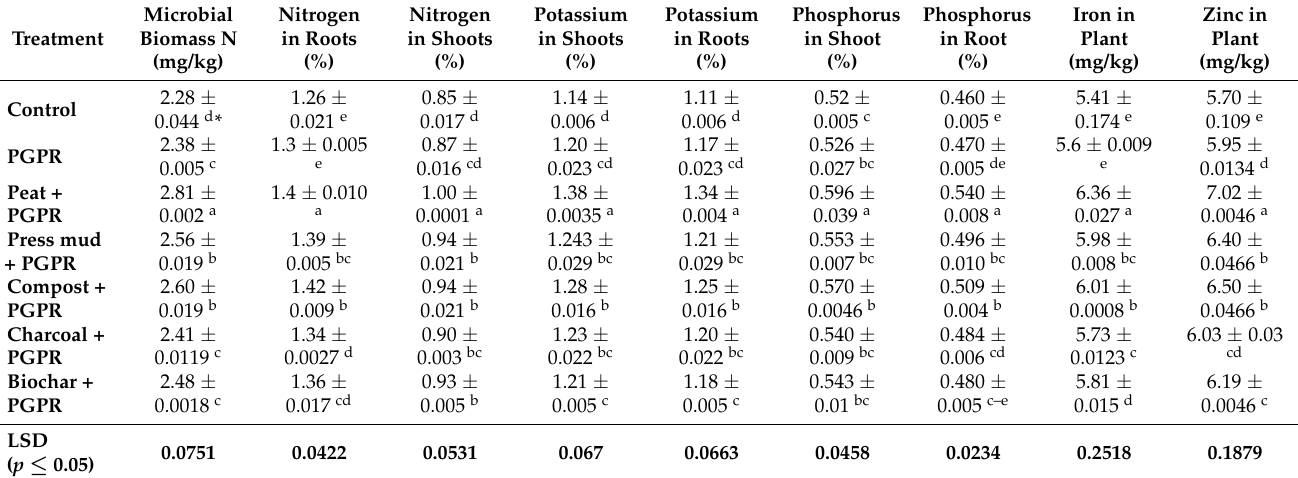
* Values are mean ± standard error of means where n = 3. Mean values with the same lettering are statistically at par ( p ≤ 0.05).